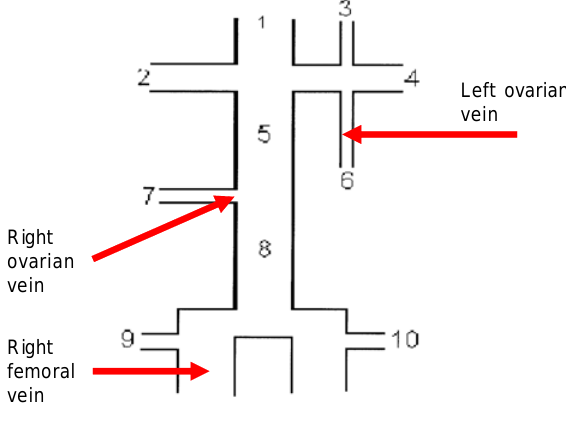
Figure 1. Ovarian vein sampling